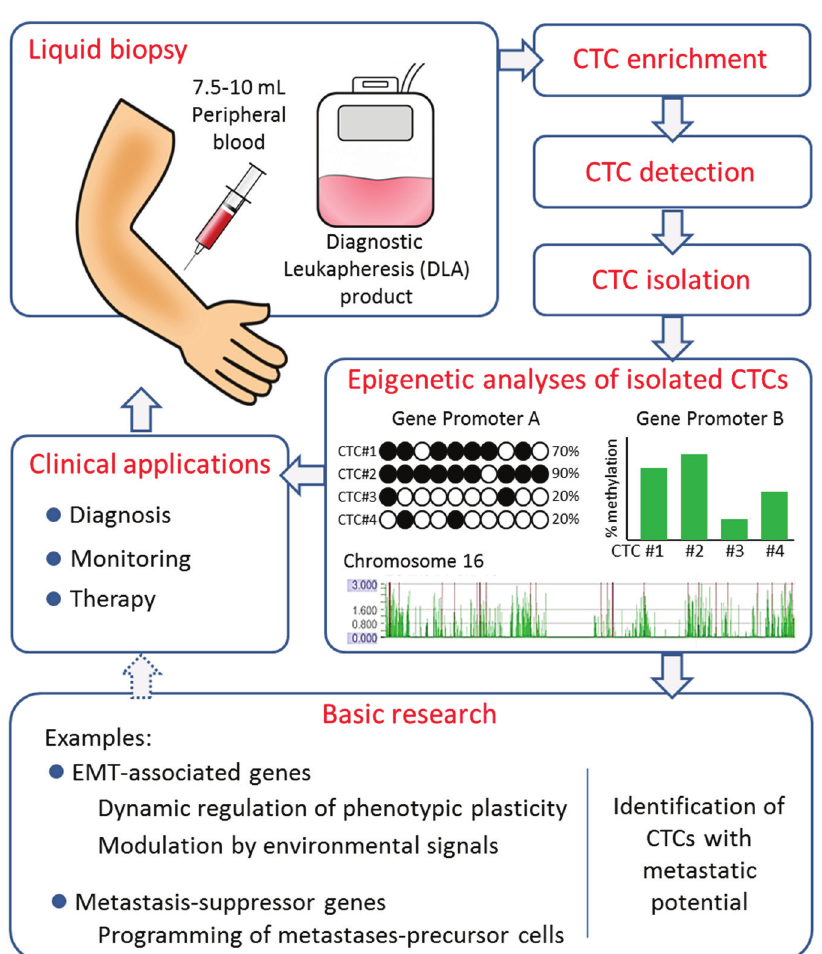
Figure 2. Potential clinical and research applications of epigenetic analyses of